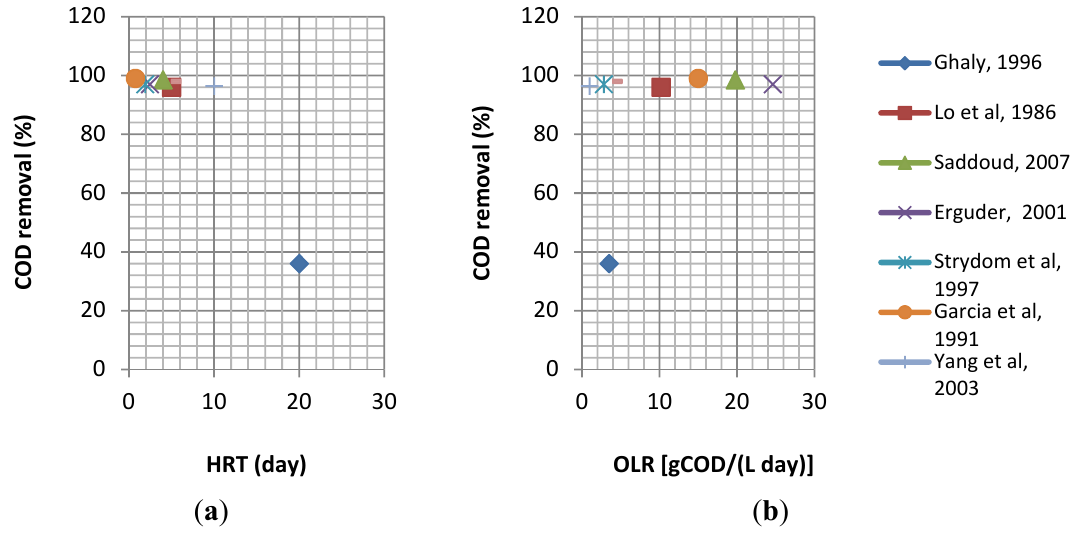
Figure 7. Maximum COD removal versus ( a ) HRT (days) and ( b ) OLR [g COD/(L day)] with the use of two phase anaerobic digestion system for CW wastewaters